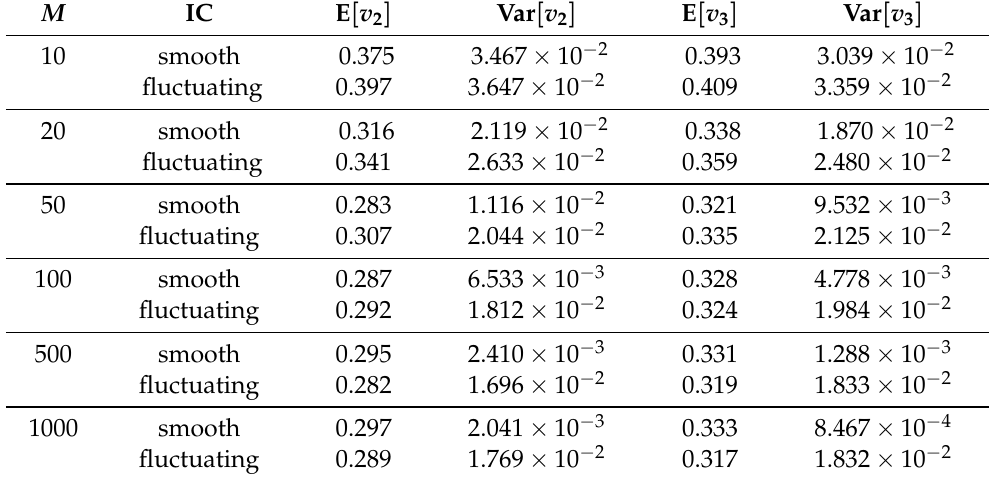
Table 1. The calculated flow harmonics and their fluctuations using the identical point-source model with N = 10. The calculations are carried out for smooth and fluctuating initial conditions with event multiplicity M = 10,20,50,100, and 500.